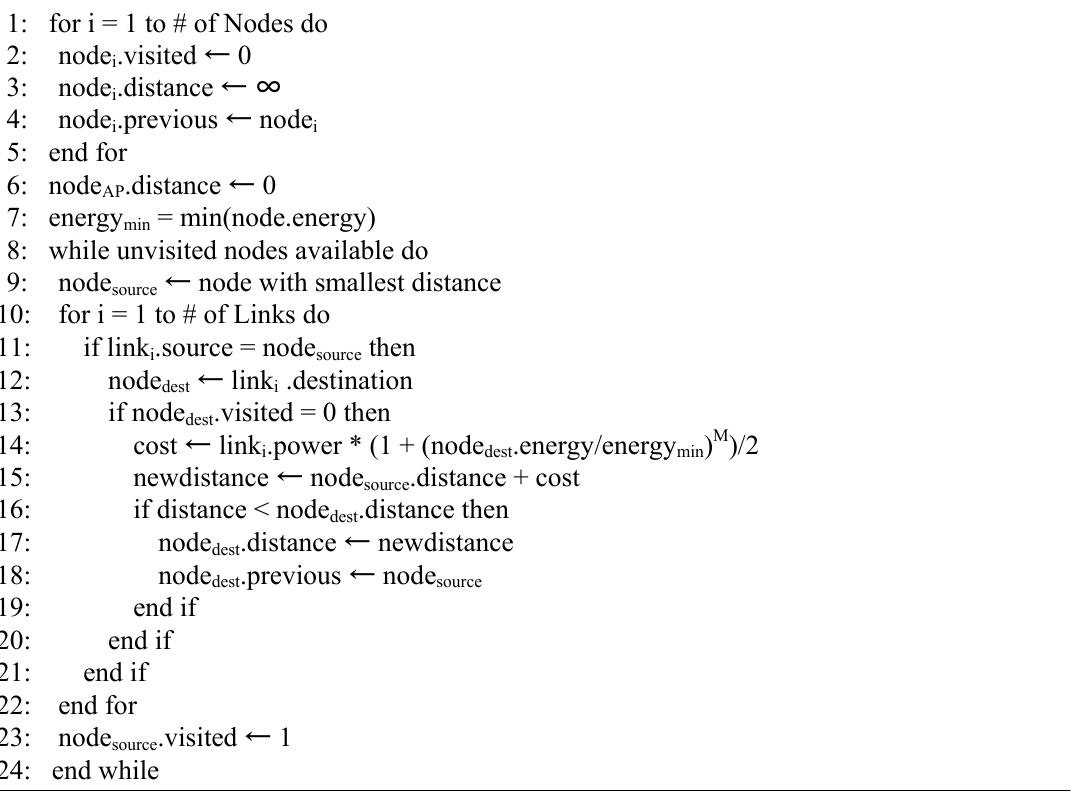
Algorithm 1. Dijkstra’s Algorithm with proposed cost function